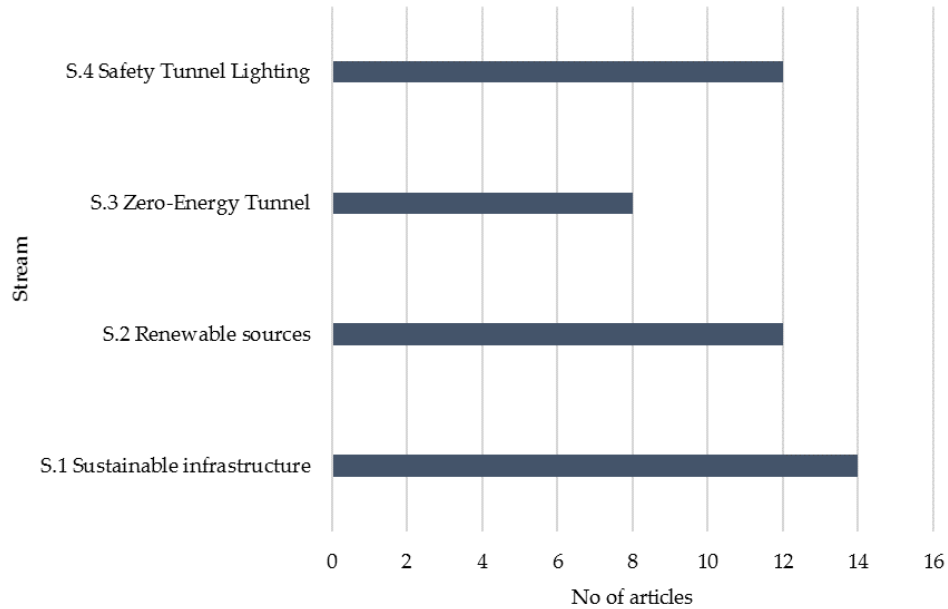
Figure 9. Number of articles per subject